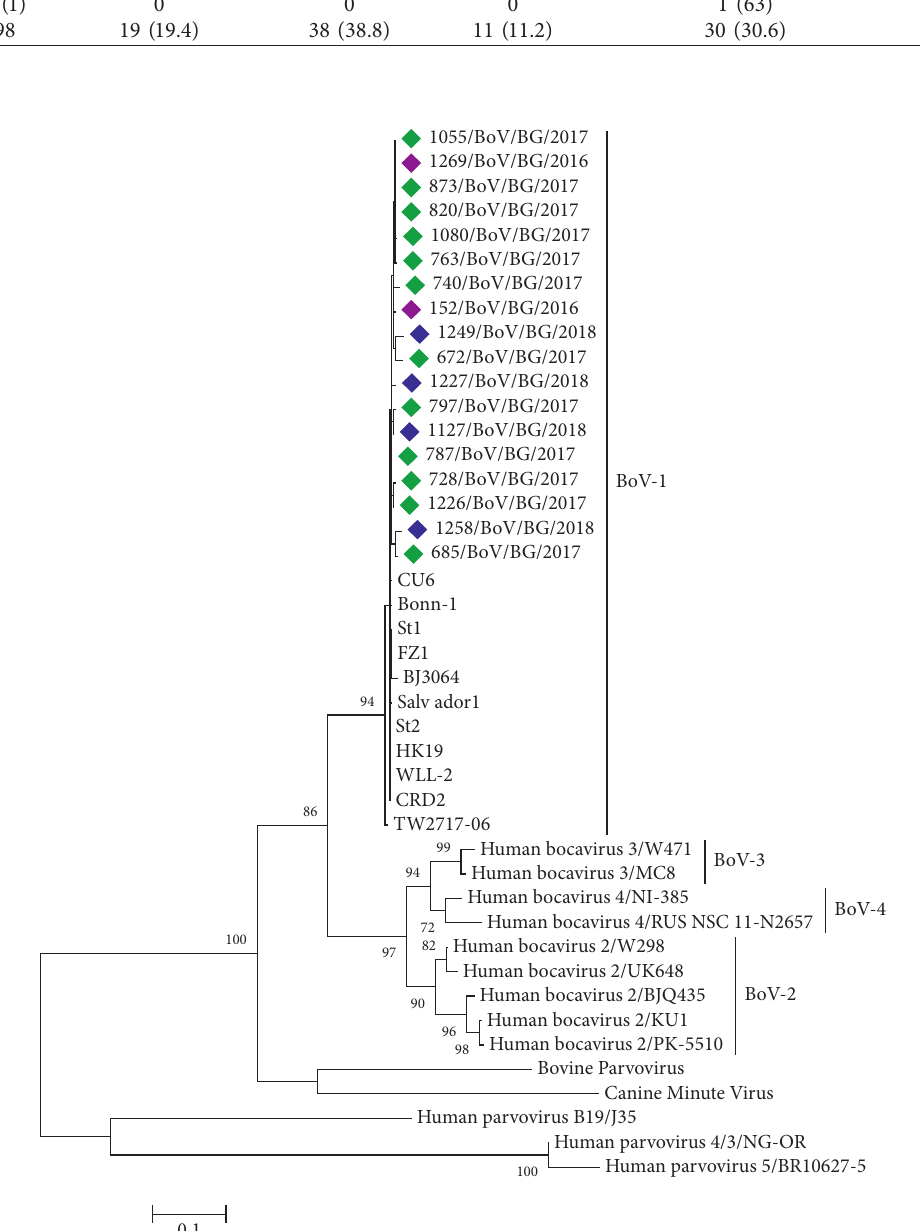
Figure 4: Phylogenetic tree based on a fragment of the VP1/VP2 gene of hBoV and other parvoviruses. Genetic distances were measured with the Tamura-3 model with gamma distribution (T92 +G). The phylogenetic tree was constructed with the maximum likelihood (ML) algorithm using MEGA software (version 6.0). The sequence of prototype hBoV strain St1 is shown in bold. The Bulgarian sequences, detected in 2016, 2017, and 2018, are shown by purple, green, and blue rhombuses,